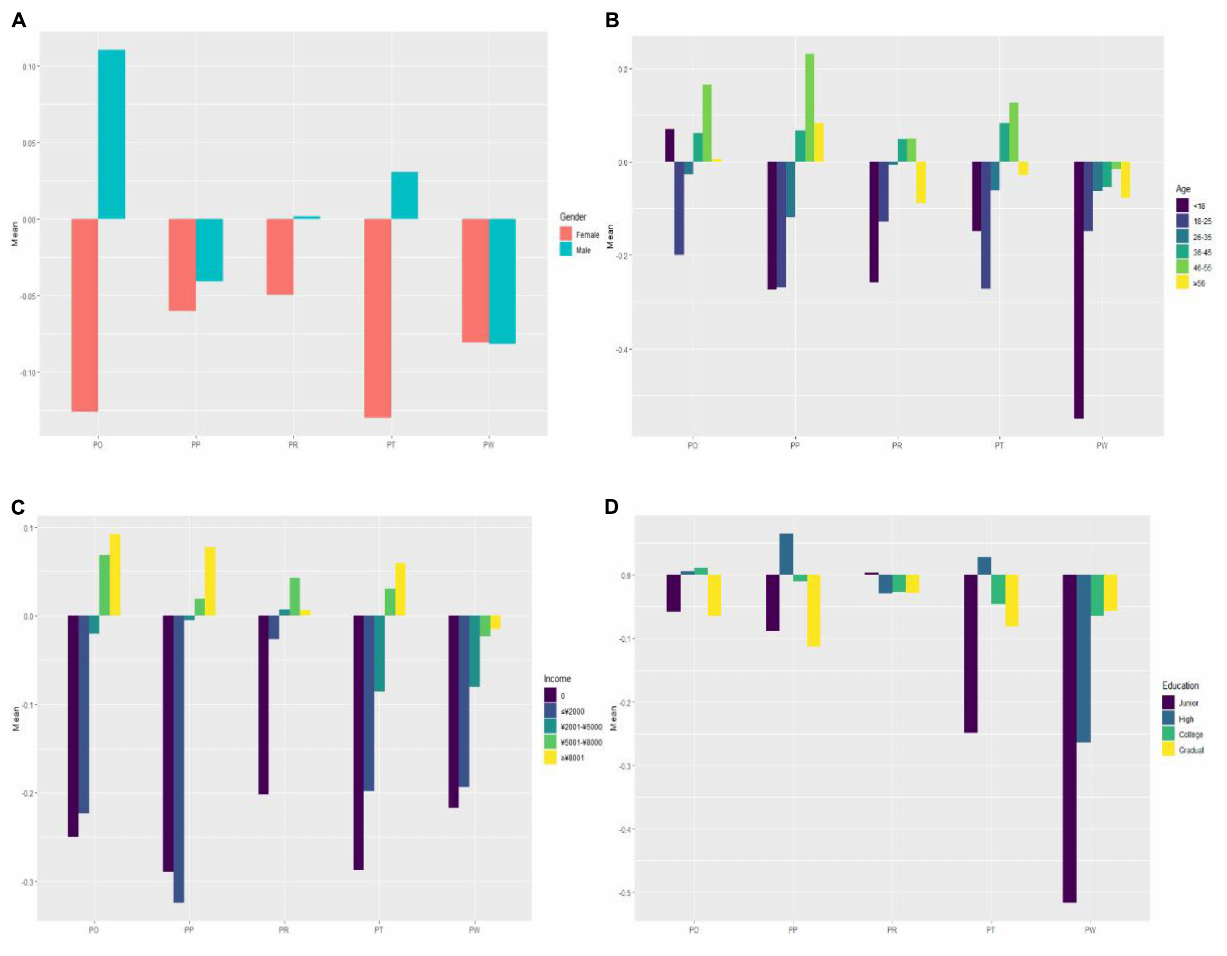
Figure 2C depicted the pandemic-induced changes in consumer purchase behavior according to monthly income levels. As